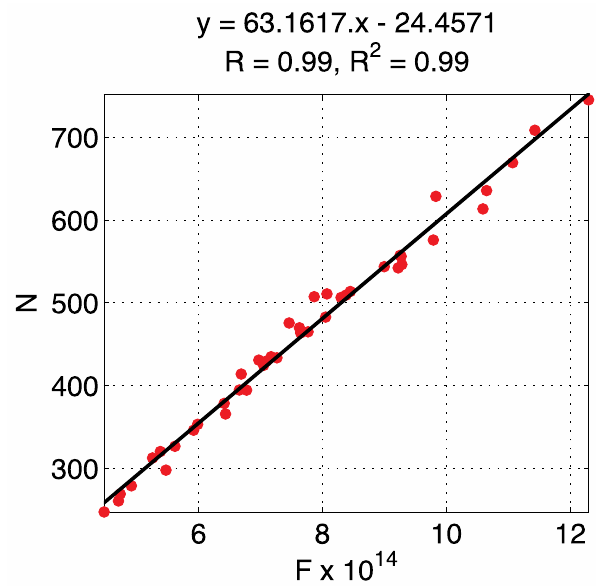
Fig. 7. Relationship between the COSMIC parameter N found by multi-parameter optimization and the factor F , this being the ratio between the number of counts observed during the COSMOS probe calibration at a specific site and the calculated neutron flux intensity given by MCNPX when run with the soil chemistry and water content (including lattice water) observed at each probe site during calibration.